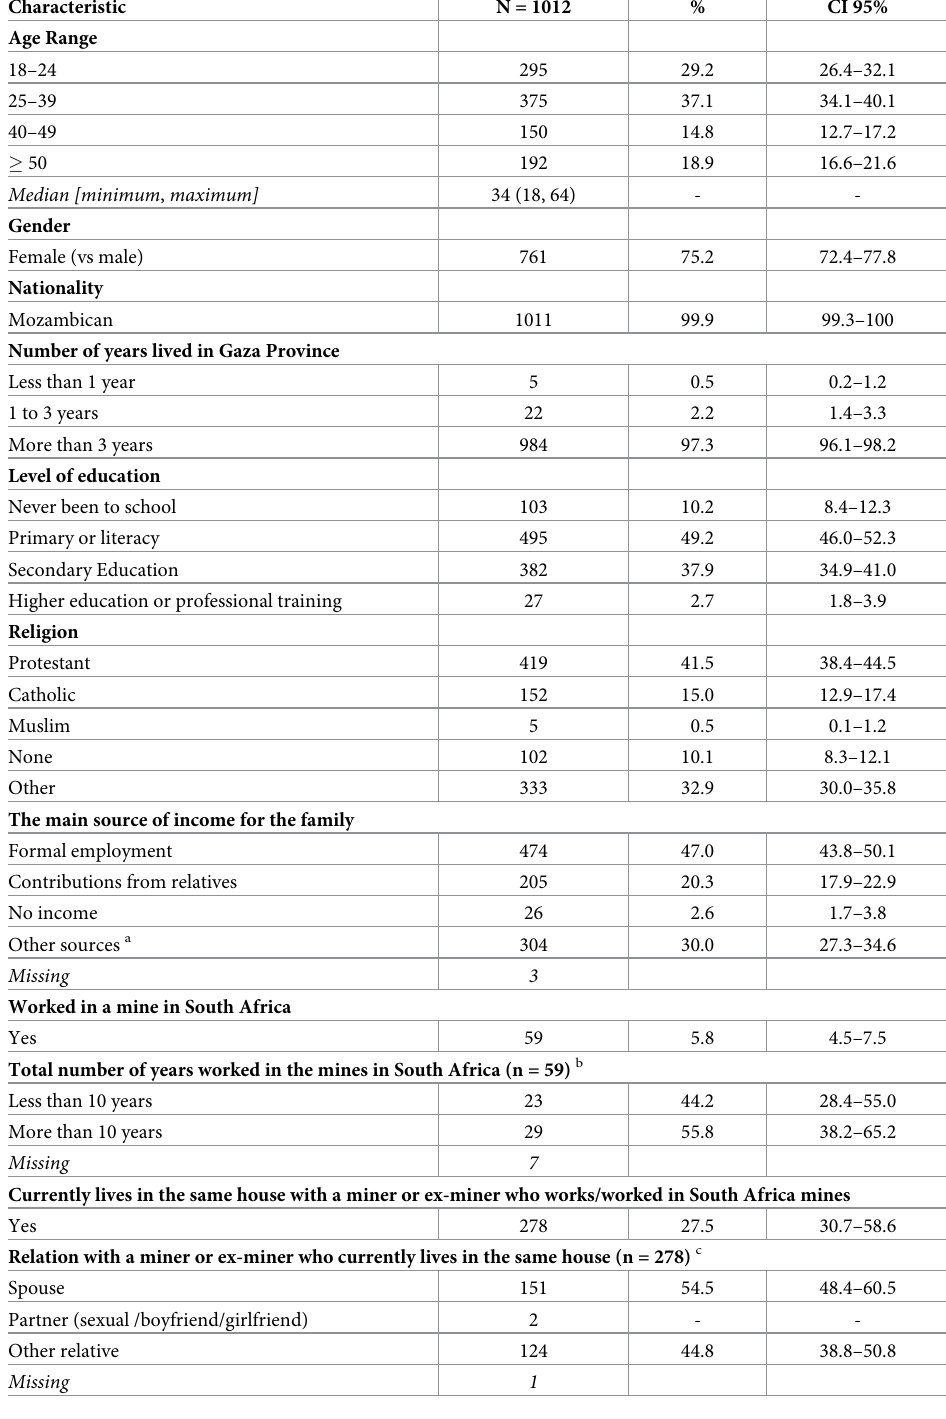
Table 1. Socio-demographic characteristics of participants, in miners community of origin, Gaza Province, Southern of Mozambique,